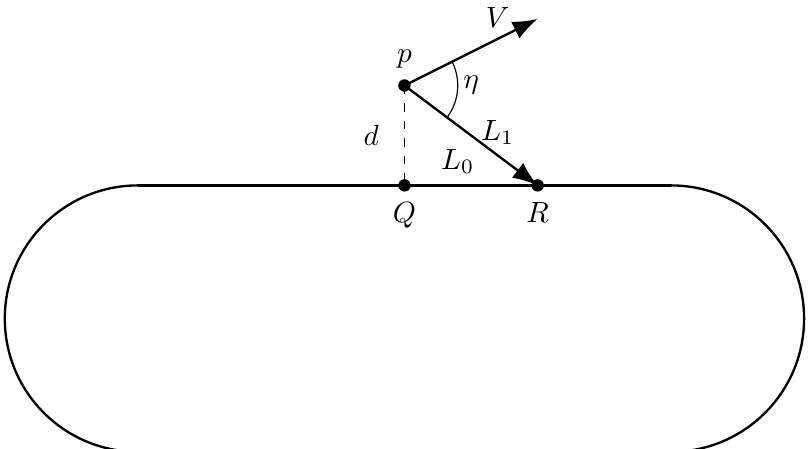
Figure 5. L 1 and L 0 guidance logic